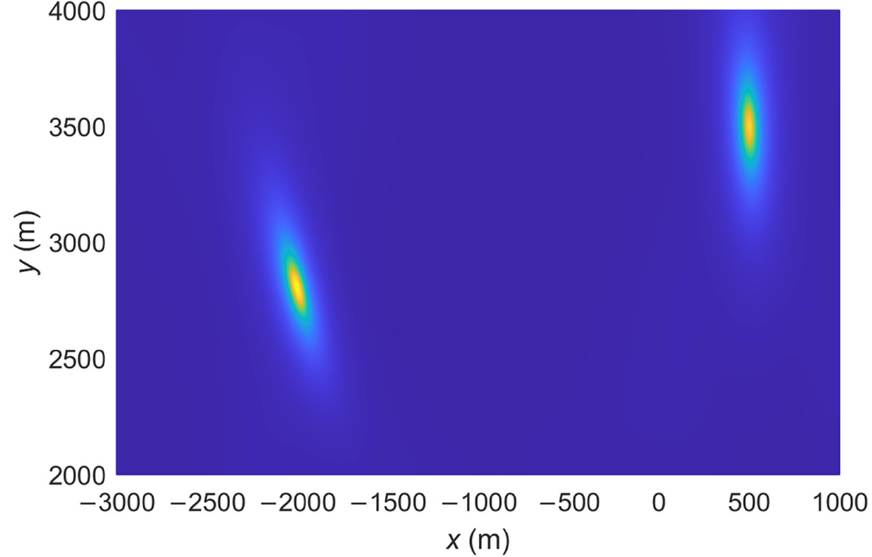
Figure 3. Spatial spectrum of ML_AOA/TOA (top view).